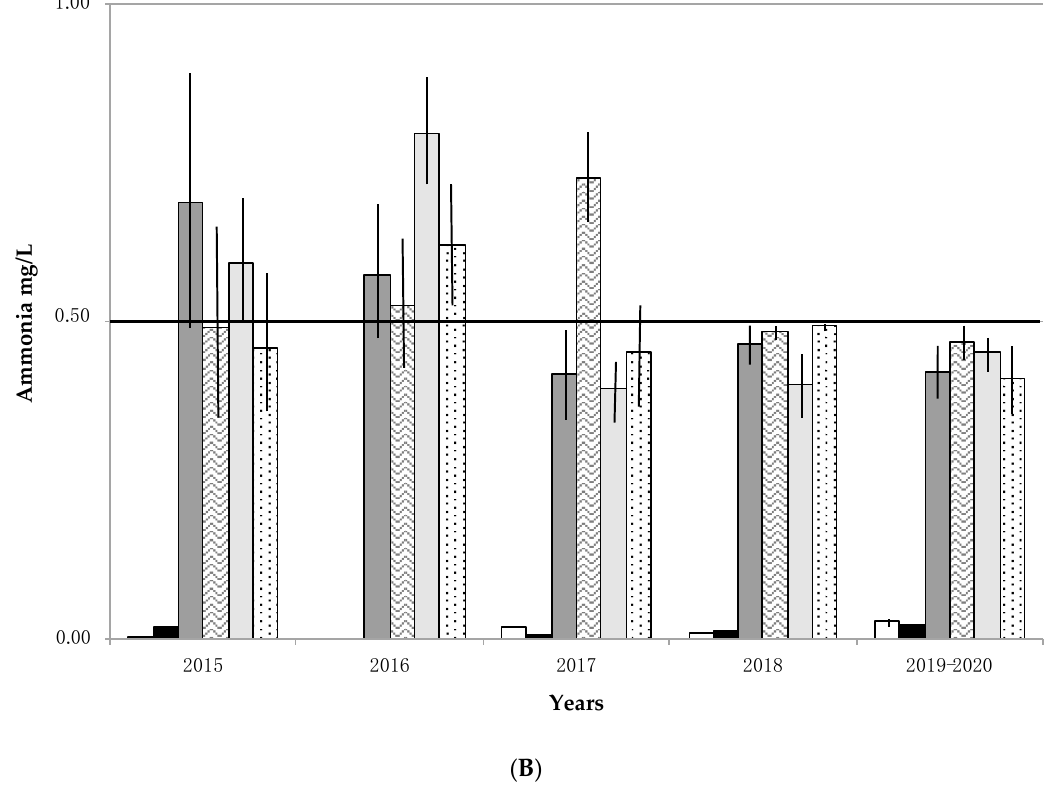
Figure 2. Trend of chlorates ( A ) and ammonia ( B ) expressed as mean ± Standard Deviation (SD) according to sampling sessions and water pipelines. Black line (700 μ g/L) indicates the provisional value for chlorate in drinking water, established by WHO. Black line (0.50 mg/L) indicates the maximum permissible drinking water ammonium value established by Italian and European legislation.